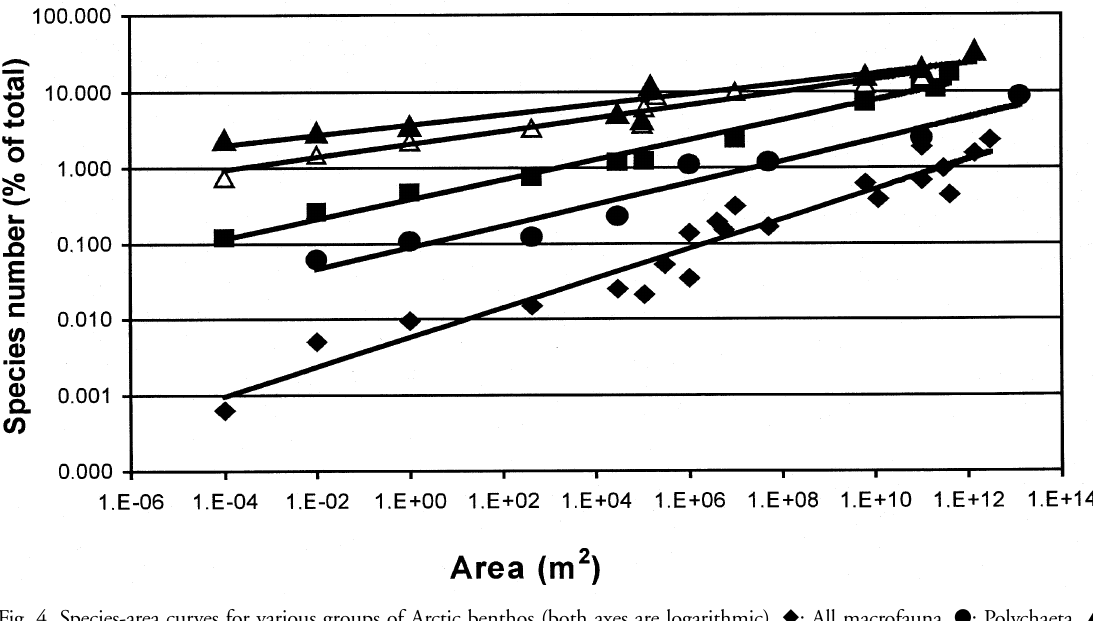
Fig. 4. Species-area curves for various groups of Arctic benthos (both axes are logarithmic). ◆ : All macrofauna, ● : Polychaeta, ▲ : Diatomea, : Ciliata, ■ : :